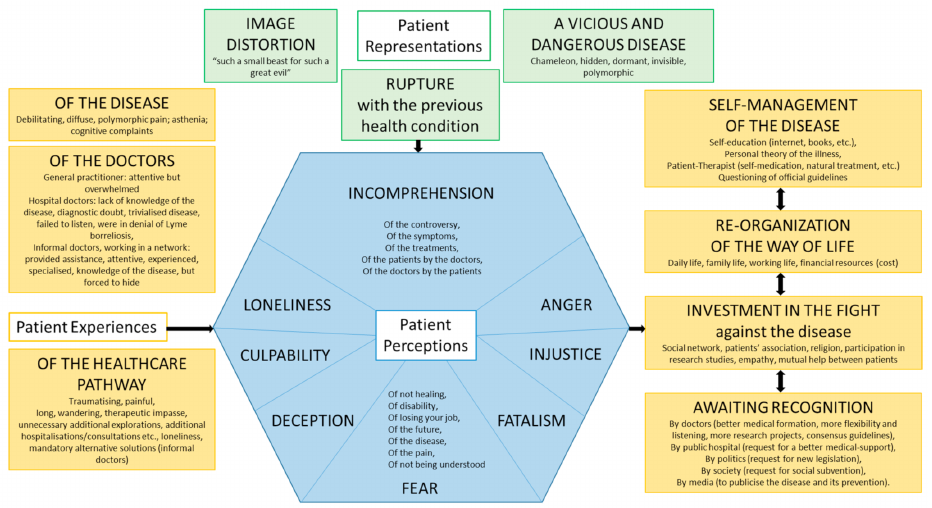
Figure 1. Model of the theory: perceptions, representations, and experiences of patients with persistent symptoms in the context of suspected Lyme